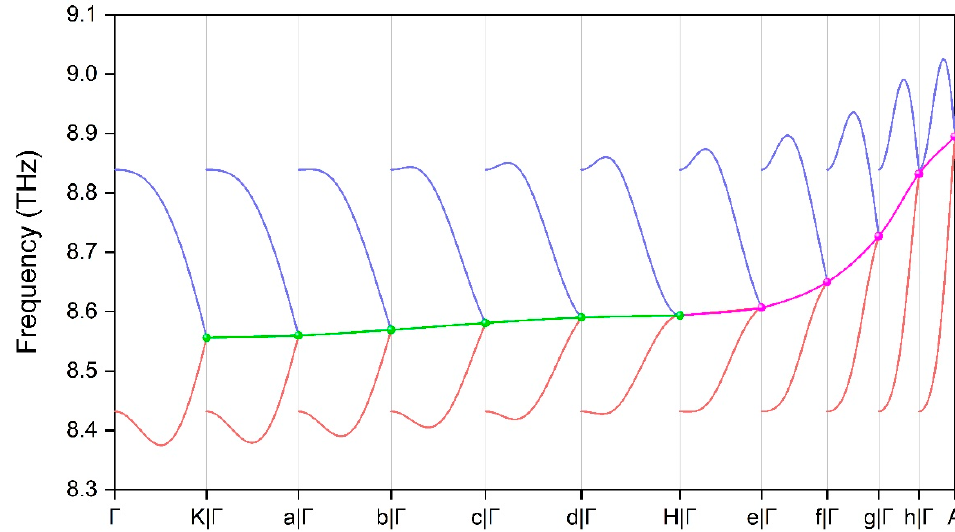
Figure 4. The precise band dispersion scan along various path segments within the k x = 0 plane. The spatial distribution of these path segments can be referred to the bottom local coordinate system in Figure 3. The overlapping points between the two bands are highlighted by the color dots and their frequency variation range can be seen by the connected line curve.